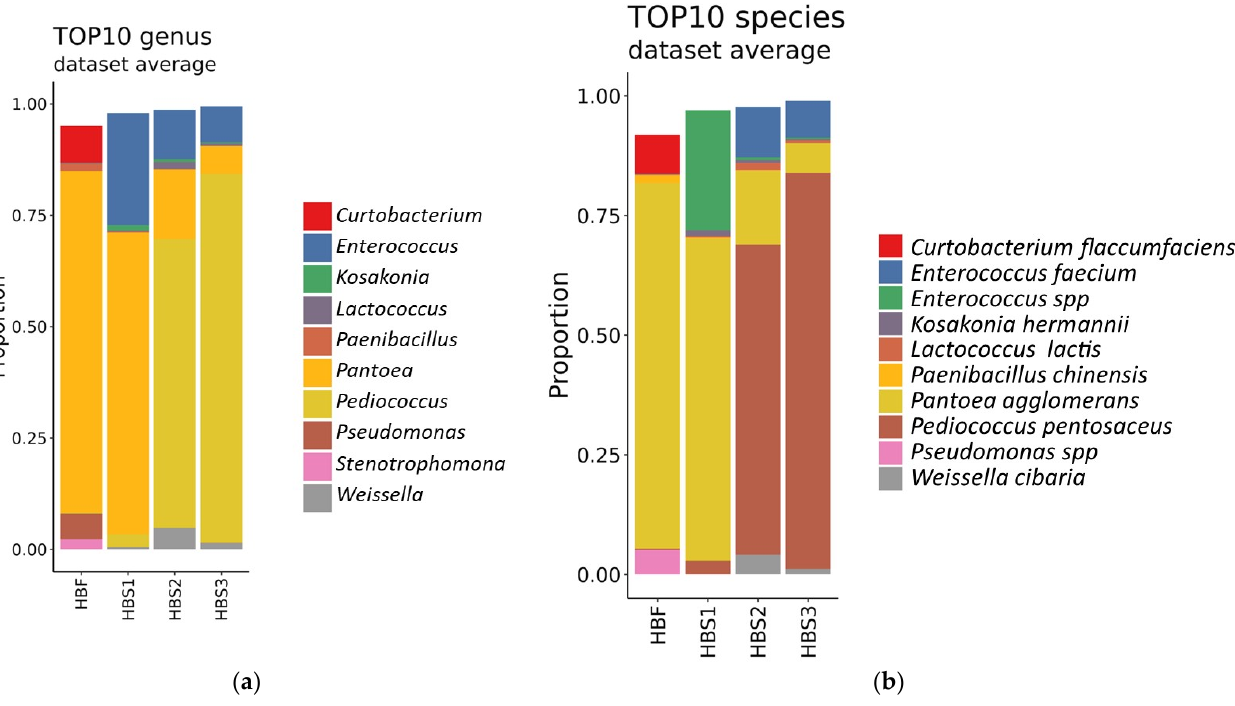
Figure 5. Taxonomic composition of the 10 most represented for selected set of bacteria. ( a )—The composition of the most represented bacteria genus for hull-less barley flour HBF and the sourdough after the 1st, 2nd, 3rd backslopping step of fermentation (HBS1; HBS2, HBS3); ( b )—the composition of the most represented bacteria species for hull-less barley flour HBF and for the sourdough after the 1st, 2nd, 3rd phase of fermentation (HBS1; HBS2,